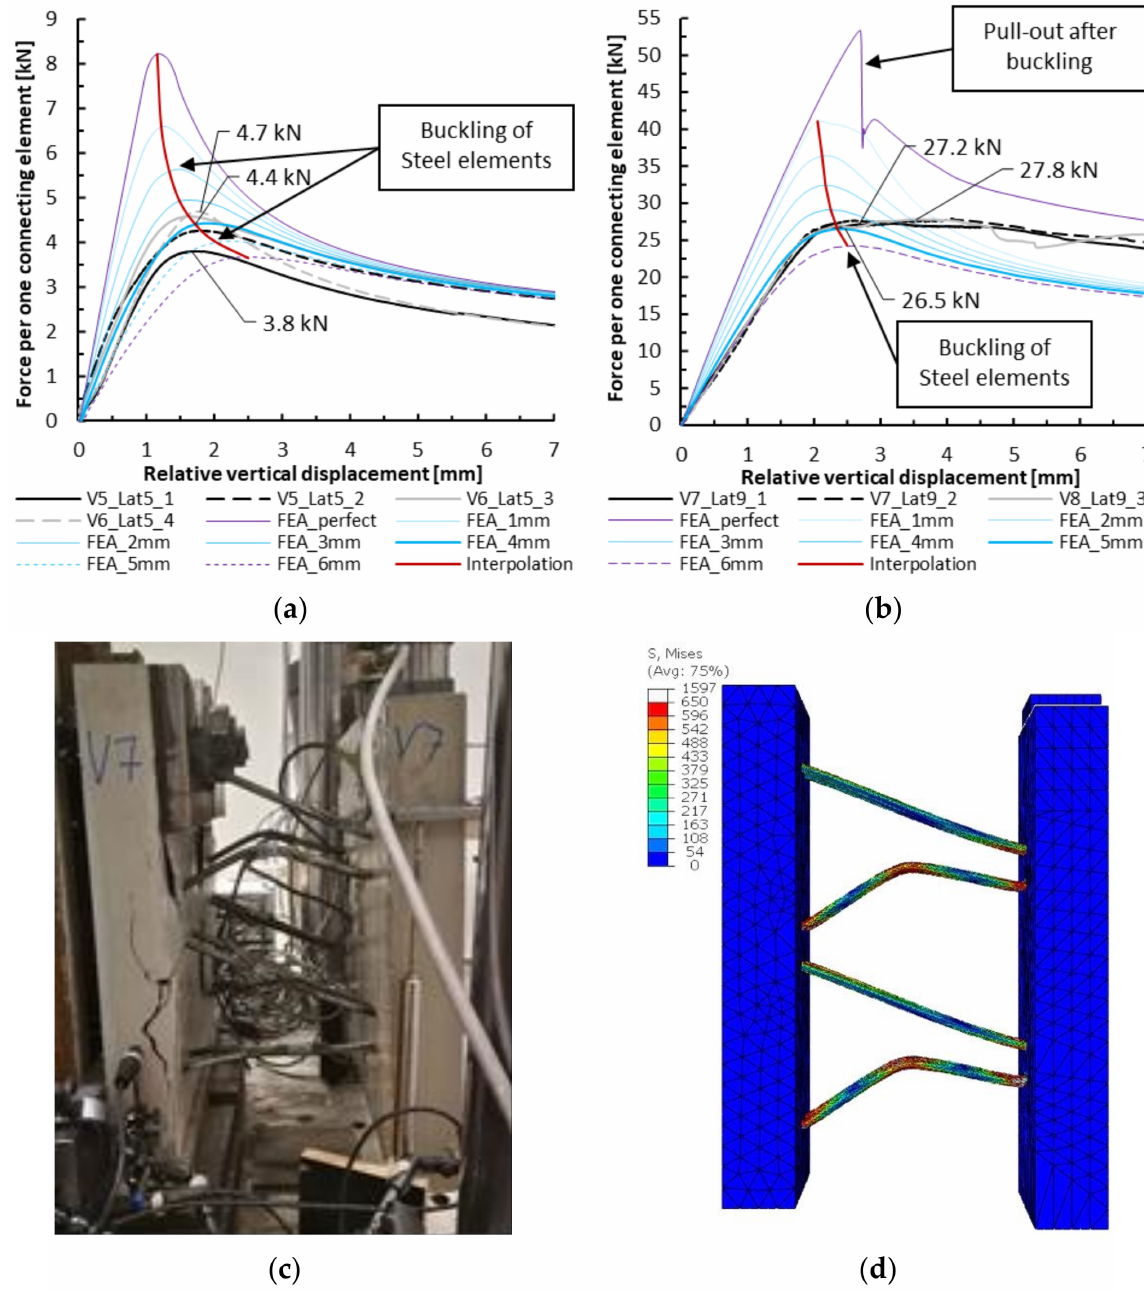
Figure 8. Test results Ø5 mm and Ø9 mm lattice girder double wall elements: ( a ) Ø5 mm lattice girder double wall elements: load-deformation diagram with results from laboratory tests (black and grey) and FEA-simulations (blue and purple); ( b ) Ø9 mm lattice girder double wall elements: load-deformation diagram with results from laboratory tests (black and grey) and FEA-simulations (blue and purple); ( c ) specimen post failure in the laboratory test; ( d ) finite element specimen post failure, deformation superelevated two